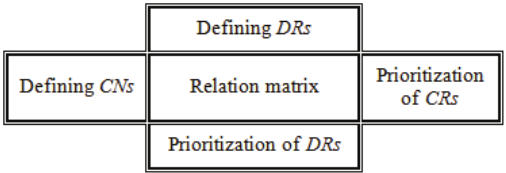
Fig. 1. Proposed HOQ